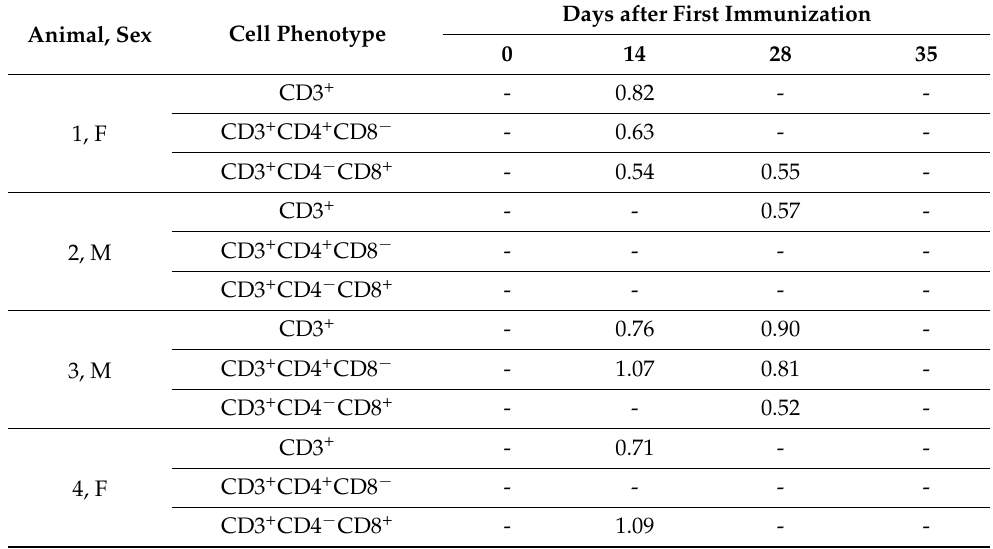
Table 1. Percentages of proliferated CD3 + , CD4 + and CD8 + T cells in immunized marmoset monkeys (n = 4; M = male; F = female) at different time points after vaccination. Values < 0.5% are considered as being below the cut-o ff .